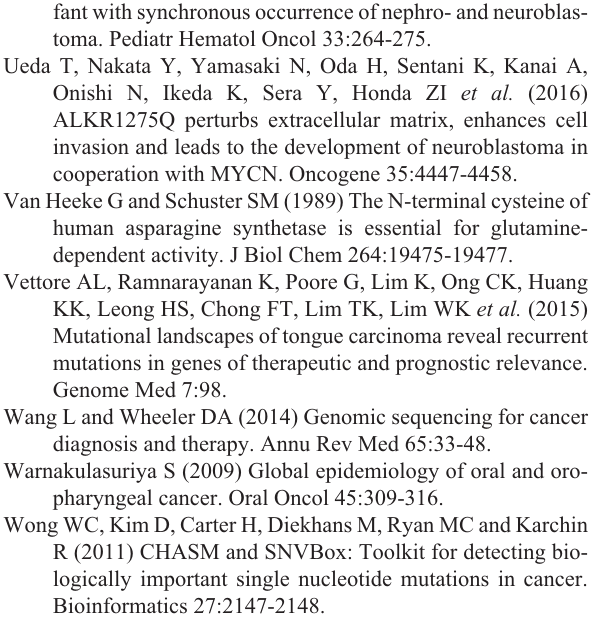
Table S1 - Whole exome sequencing data summary. Table S2 - Somatic non-coding single nucleotide variants (SNVs) found in (cid:4) 2 HNSCC patients. Table S3 - Genes with somatic mutations in HNSCC pa- tients resulting in nonsense or splice site variants. Table S4 - Significant single nucleotide variant (SNV) mu- tations in HNSCC patients in non-coding